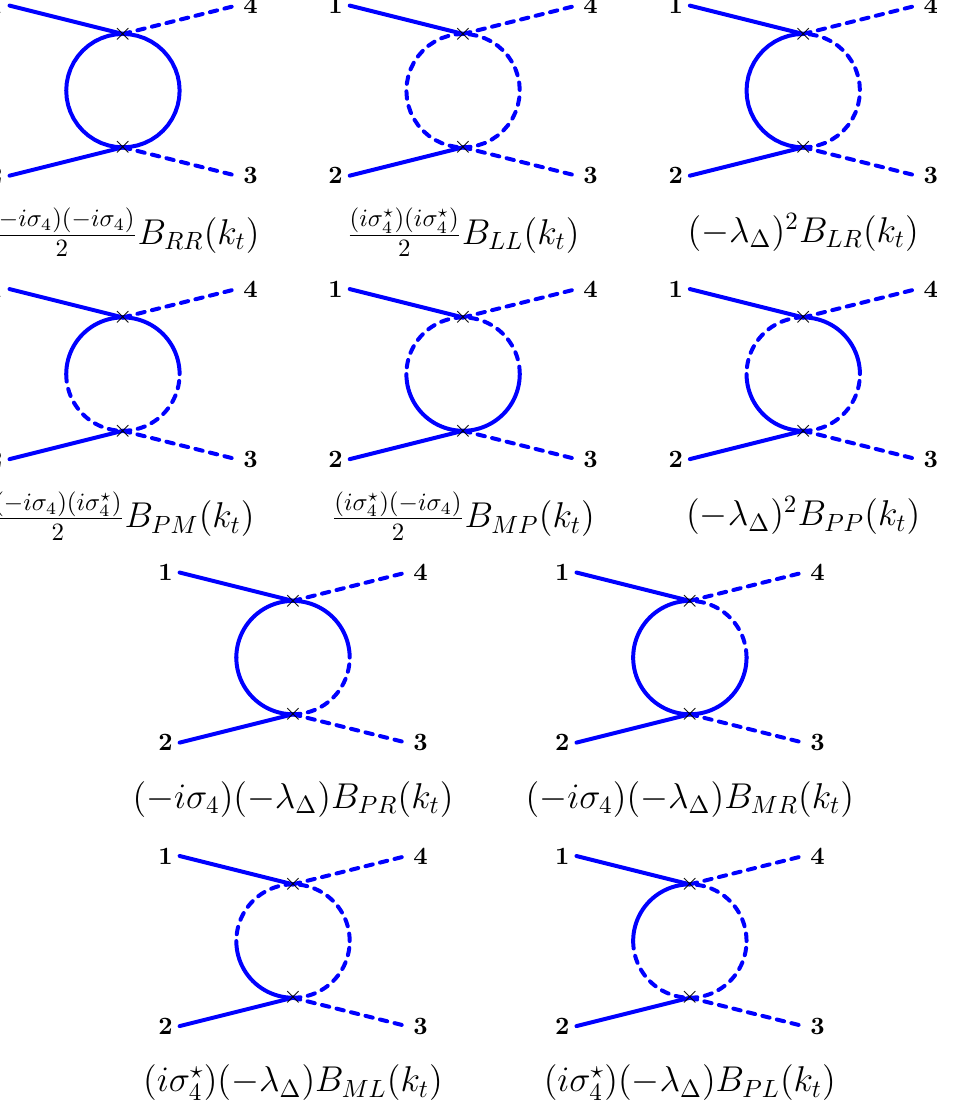
(cid:30) L (cid:30) L (Here k t = !